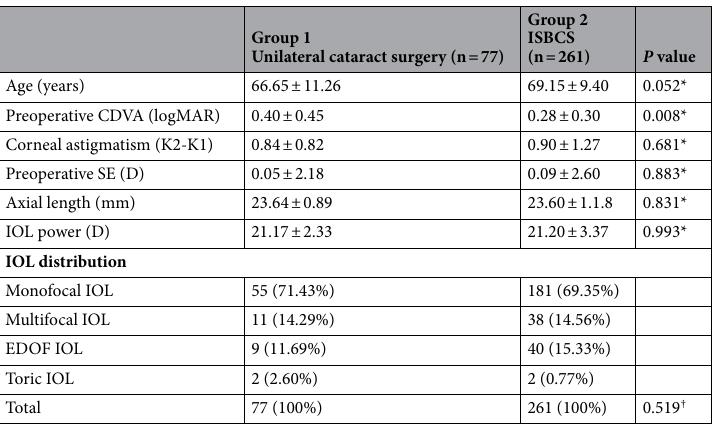
Table 1. Patient demographics and preoperative data. CDVA, corrected distance visual acuity; EDOF, extended depth-of-focus; IOL, intraocular lens; ISBCS, immediate sequential bilateral cataract surgery; SE, manifest spherical equivalent. *Student’s t test. † Pearson’s chi-square